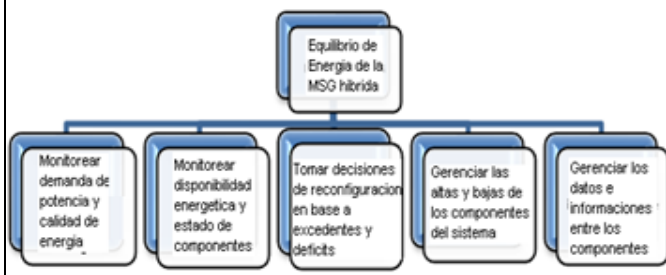
Figura 4: Funciones principales de gestión energética en una MSG. Fuente: Los autores,